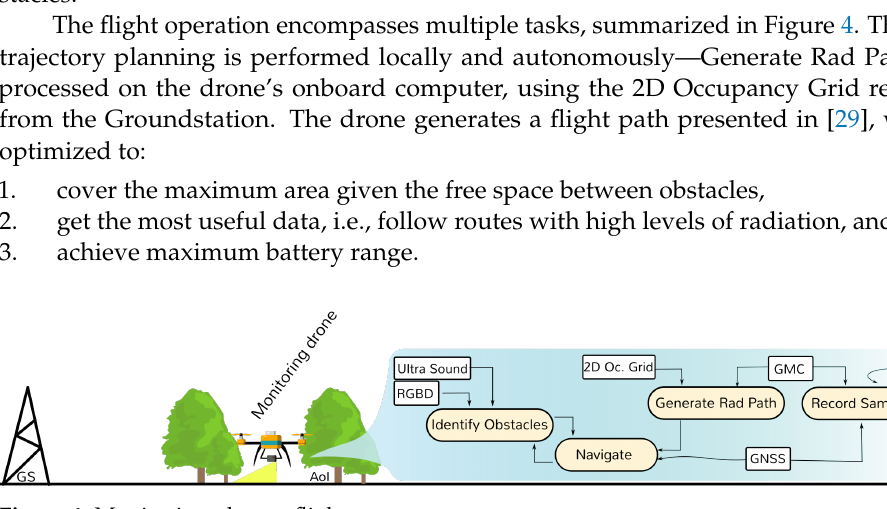
Figure 4. Monitoring